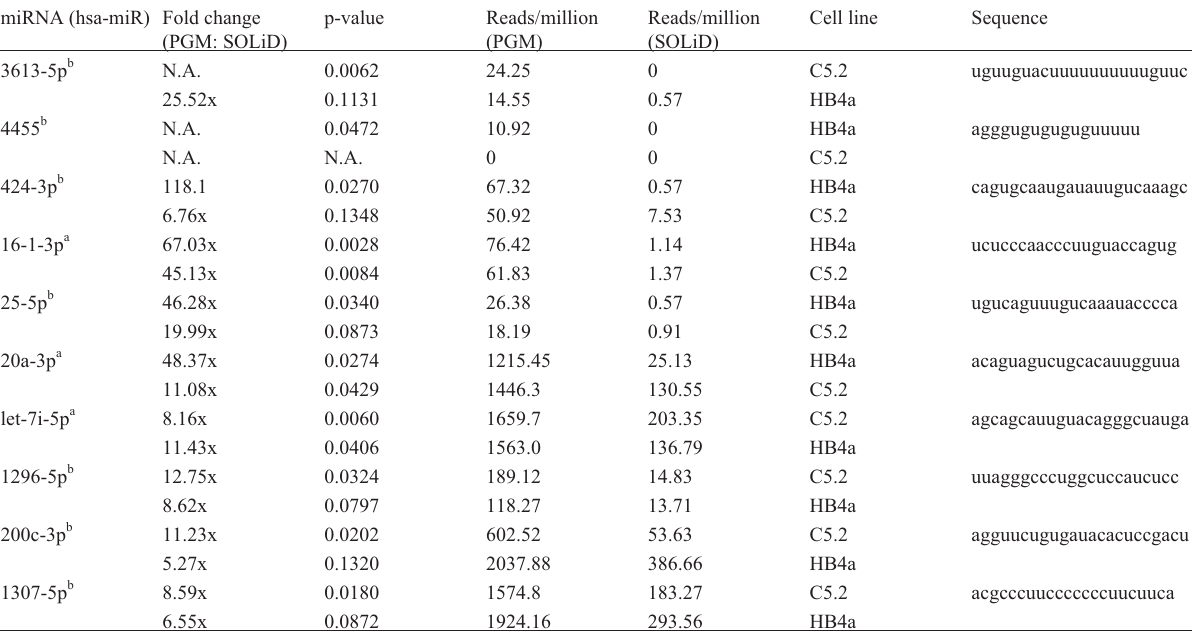
Table 3 - miRNAs more abundantly detected by the PGM platform. miRNA (hsa-miR) Fold change (PGM: SOLiD)